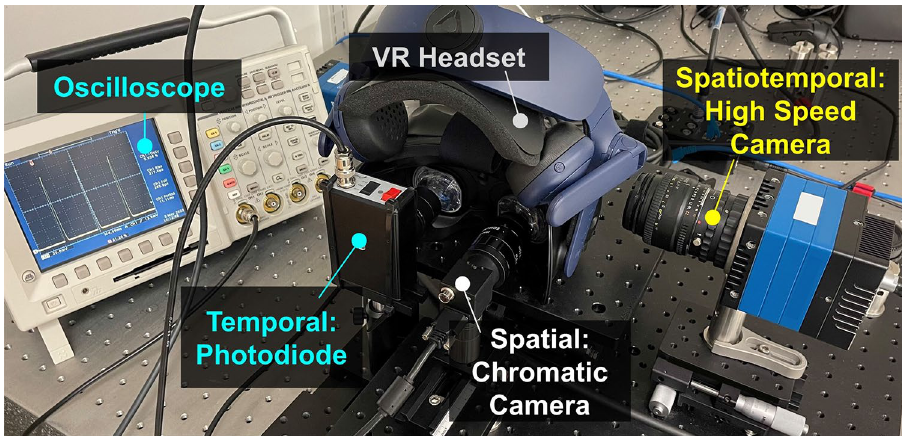
Figure 1. Experimental bench setup of spatial, temporal, and spatiotemporal measurements for VR